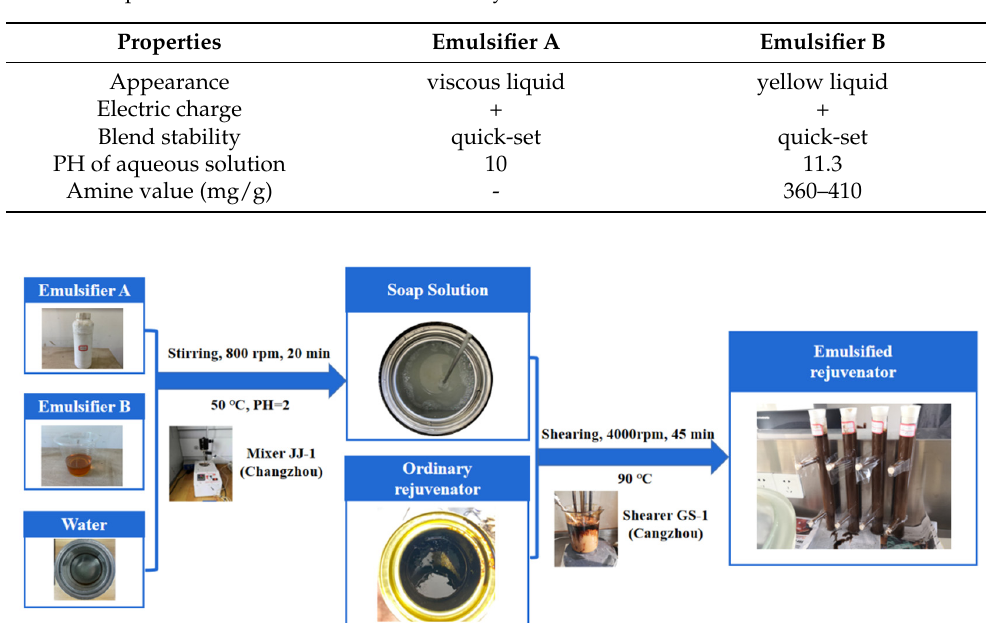
Figure 1. Flowchart of preparing ER.